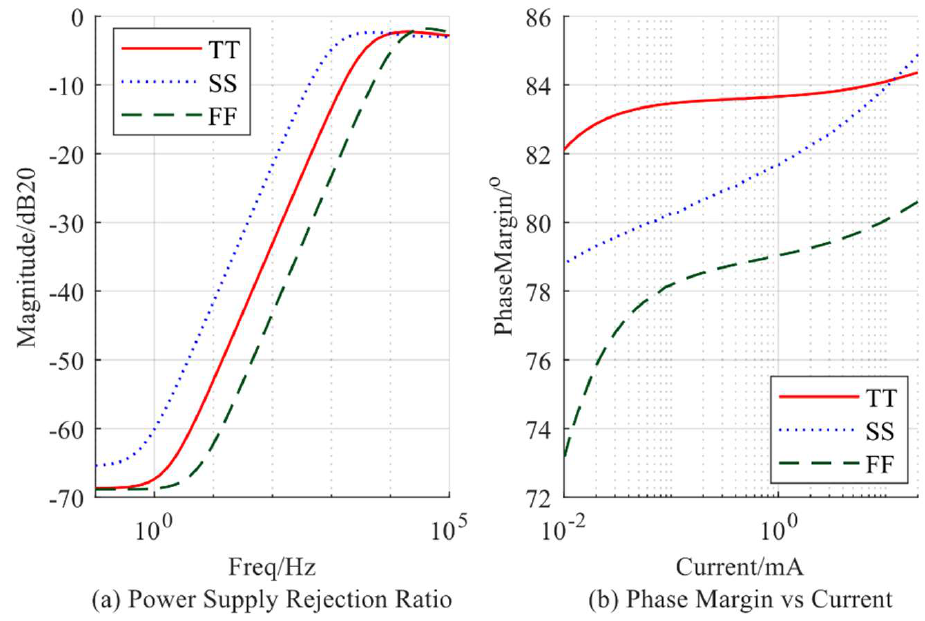
Figure 12. Power Supply Rejection Ratio and Phase Margin vs. Current.